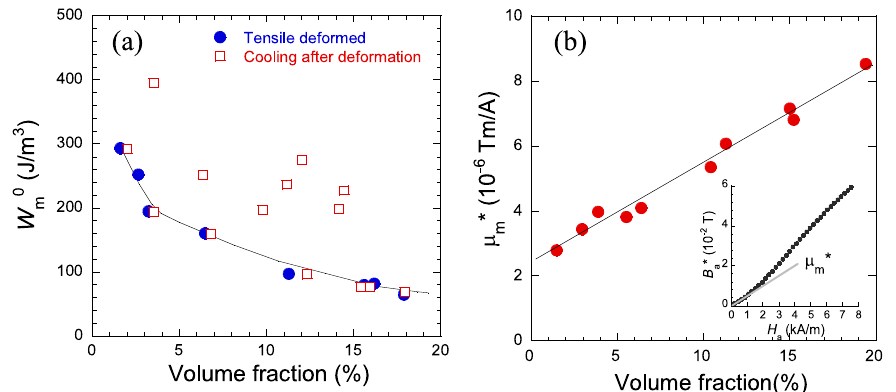
Figure 5. ( a ) W m0 as a function of the volume fraction of α′ -martensites. The solid and open symbols denote the data before and after cooling at 77 K for 5 min. ( b ) Minor-loop permeability ( µ m *) as a function of volume fraction. The inset shows B a * as a function of H a . µ m * was obtained from a linear part of the B a *- H a curve below ( H a = 1 kA/m). Here, the step of field increase was about 100 A/m,